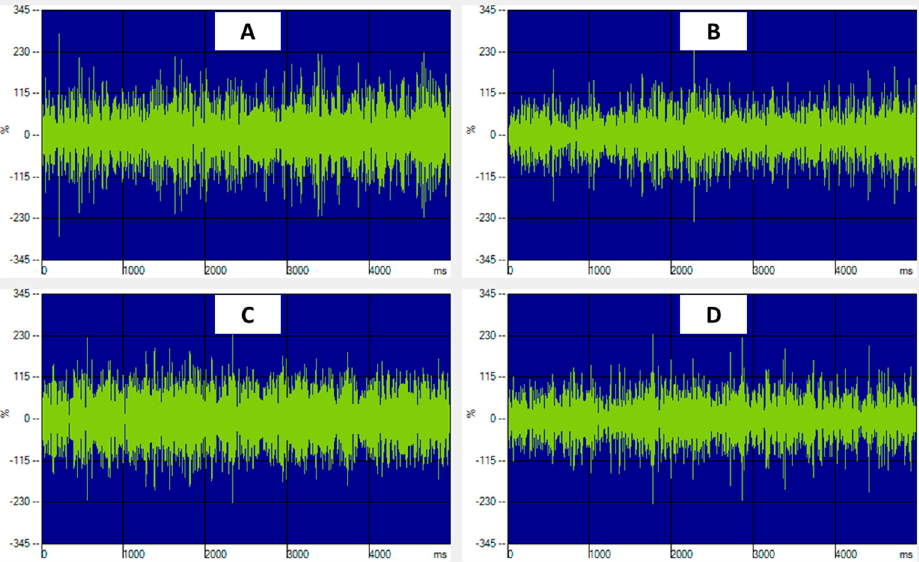
Figure 2. ( A – D ) Example of an electromyographical signal of the muscles activated during clenching. X -axis: time (ms), Y -axis: intensity of activation (µV/µV × 100). ( A ) right anterior temporalis muscle; ( B ) left anterior temporalis muscle; ( C ) right masseter muscle; ( D ) left masseter muscle.